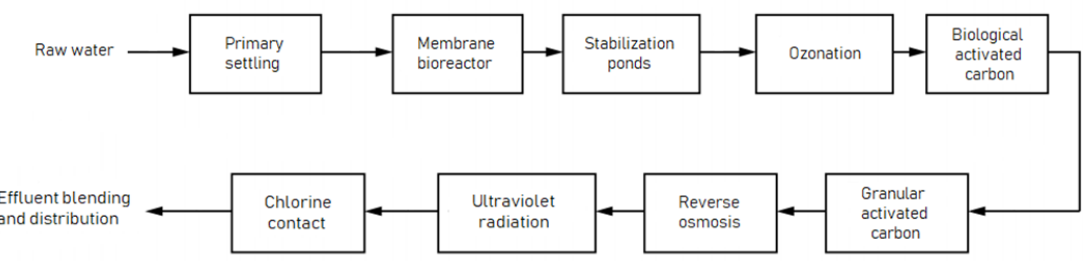
Figure 2. Wastewater treatment train.